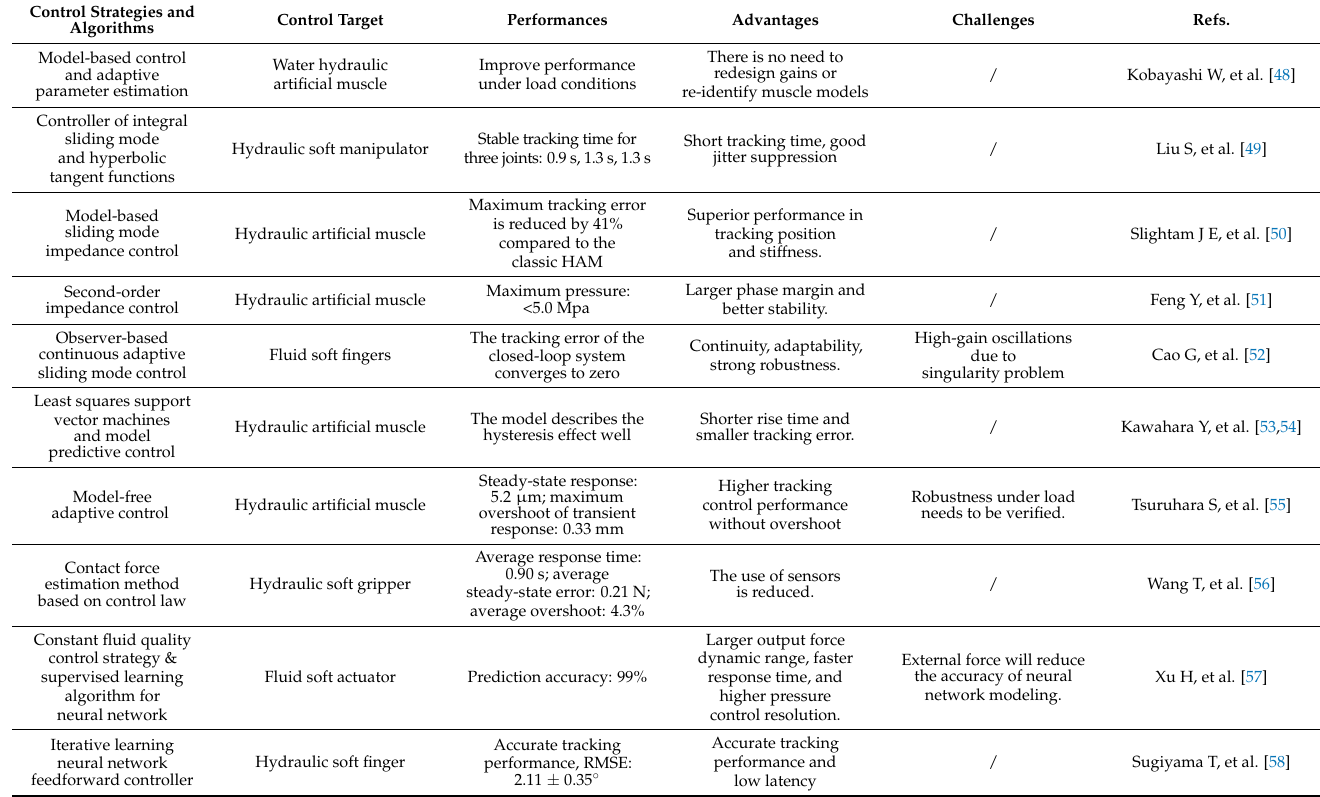
Table 3. Summary of control strategy for hydraulic soft